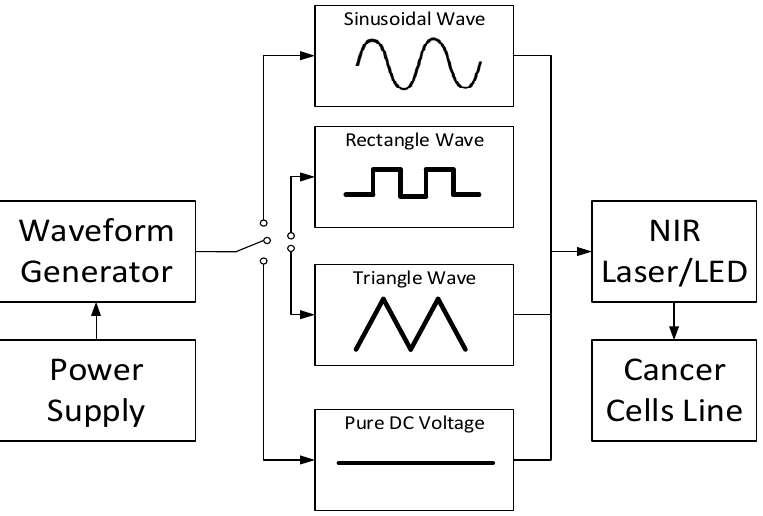
Figure 4. Single-wavelength NIR with four different waveforms instrumentation. Another instrument may be established using the combination of NIR-I, NIR-II, and visible light, as shown in Figure 5. To provide appropriate voltage to power the NIR-I, NIR-II, and visible light, a power regulator is utilized to arrange the power distribution for each light source. To minimize the power of light intensity and to focus the light radiation, a filter lens for every light source is directed to the light before illuminating the cancer cell line. Subsequently, their combinations may be integrated to enhance the cancer growth control system ability. Moreover, it is possible to assign any visible light to a specific wavelength; then, various NIR-I and NIR-II spectral windows can be implemented to obtain a comprehensive report corresponding to their incorporation.